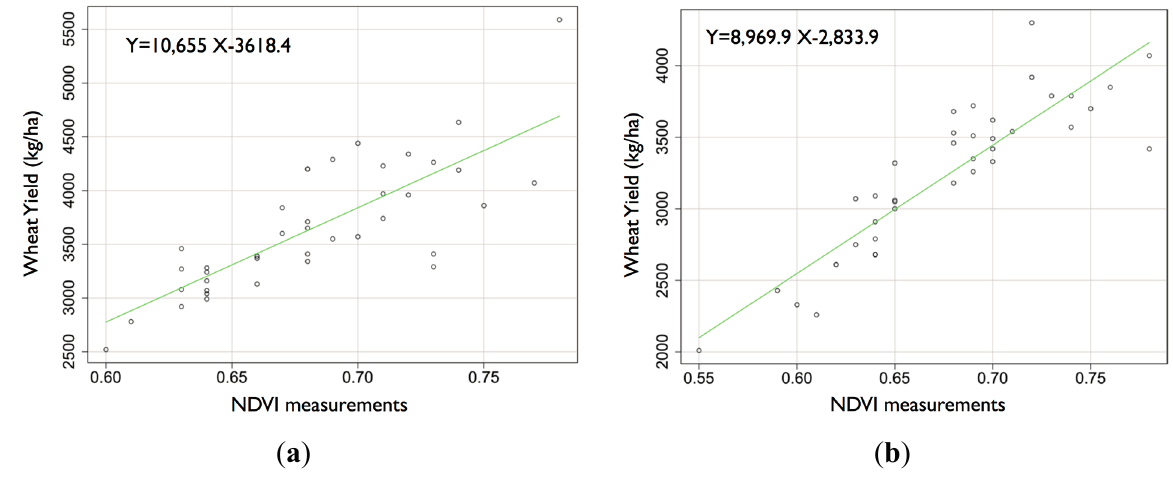
Figure 4. Relationship between the NDVI measurements and wheat yield ( a ) for field 1 and ( b ) for field 2.